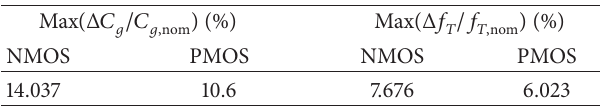
Table 1: Max (Δ𝐶 𝑔 /𝐶 𝑔, nom ) and Max (Δ𝑓 𝑇 /𝑓 𝑇, nom ) . Max (Δ𝐶 𝑔 /𝐶 𝑔, nom ) (%)